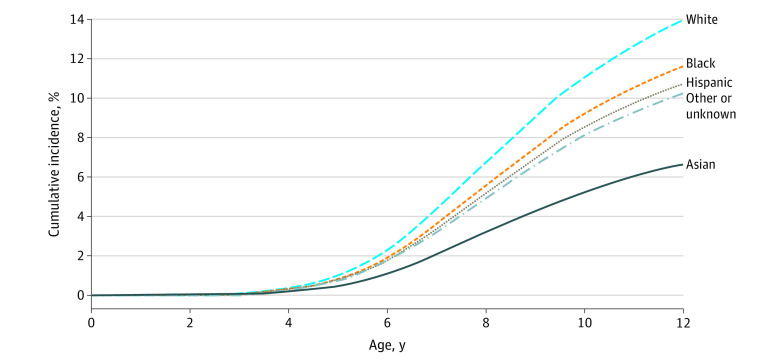
Adjusted Cumulative Incidence by Race and EthnicityThis graph was produced using stcurve following stcox in Stata version 16.1 (StataCorp).